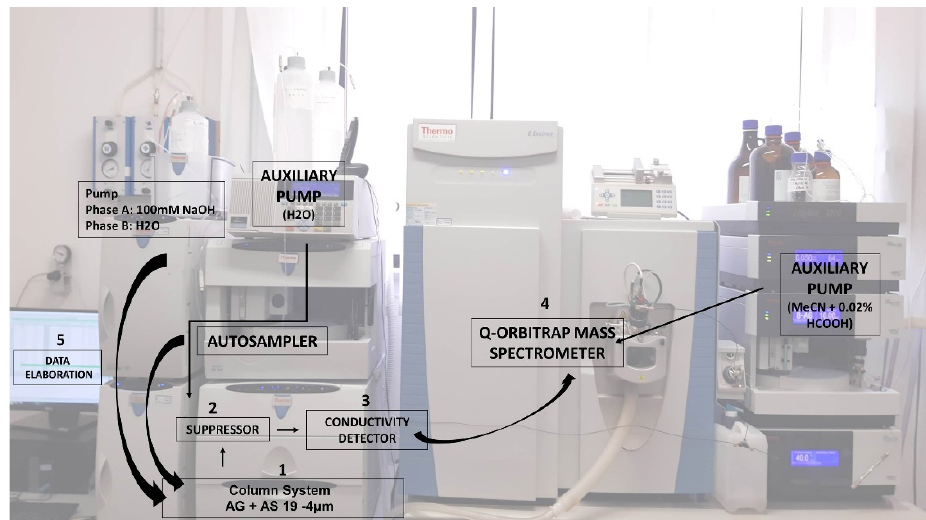
Figure 1. Configuration of the IC-HRMS system: (1) the column system (precolumn and chroma- tographic column); (2) suppressor; (3) conductivity detector; (4) mass spectrometer (Q-Orbitrap); and (5) data elaboration.